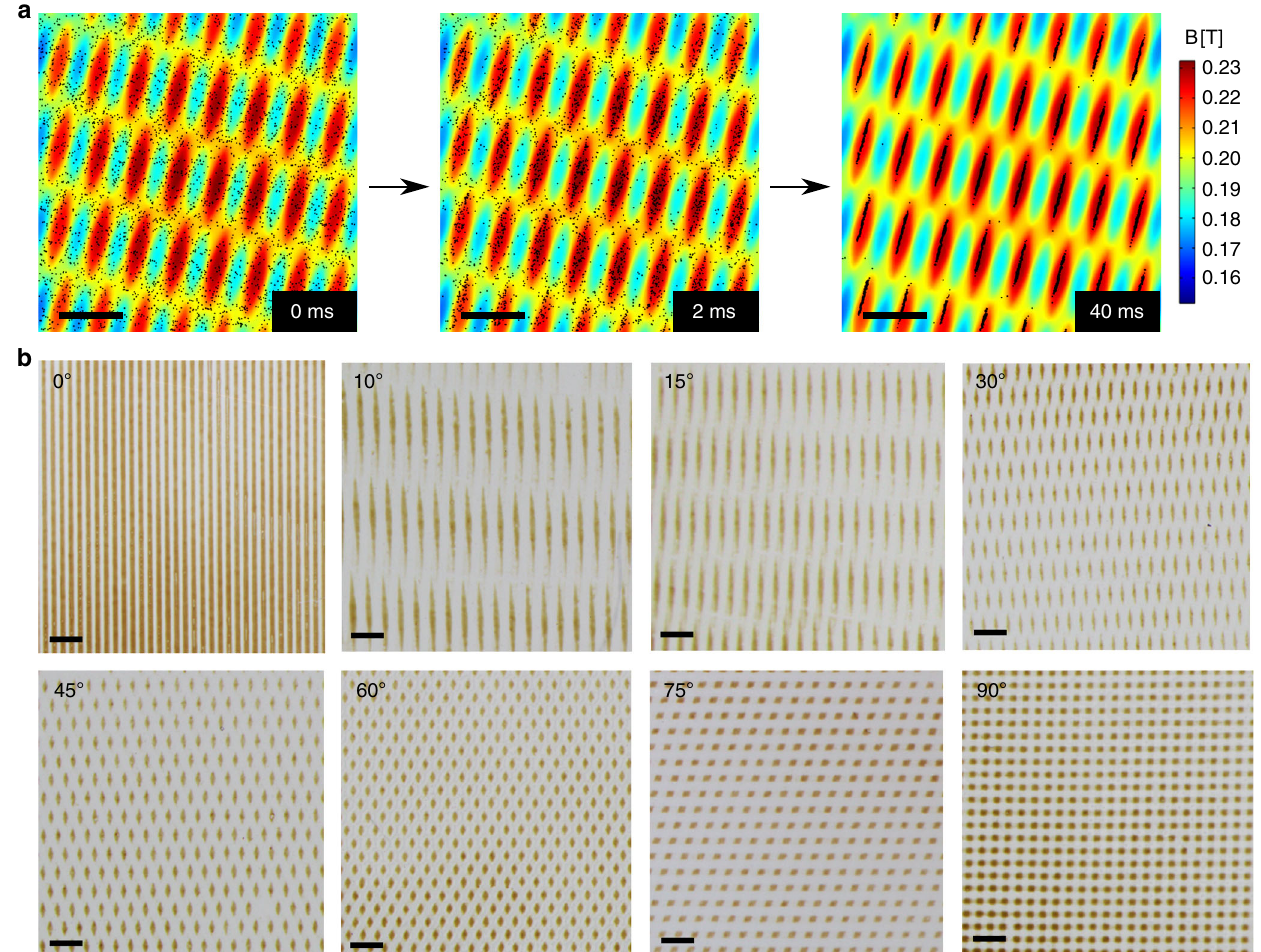
Fig. 2 Moiré-like patterns forming by the superposition of static magnetic fi elds. a MD simulation of magnetic NPs moving into high- fi eld regions produced by two arrays of parallel magnetic lines placed at θ = 30 o with respect to one another. See also Supplementary Movies 2 and 5. b Optical micrographs of nanoparticle/polymer fi lms forming between two line patterns at different angles or rotation (from θ = 0 o to θ = 90 o ). Scale bars in a and b are 100 μ m and 500 μ m,